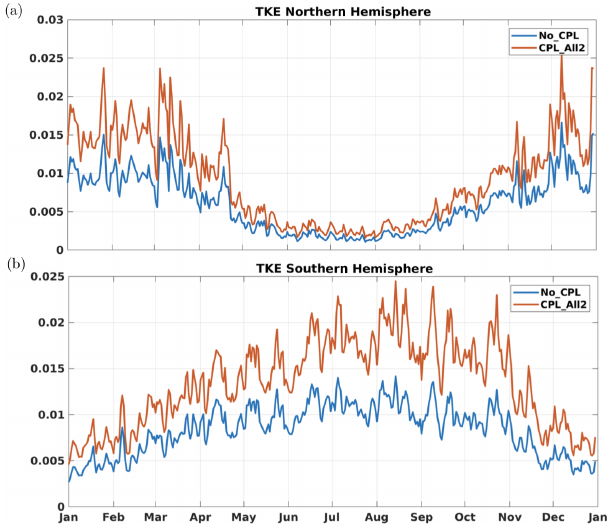
Figure 7. Spatially averaged turbulent kinetic energy (m 2 s − 2 ) at 1m of depth over (a) the Southern Hemisphere and (b) the Northern Hemisphere.